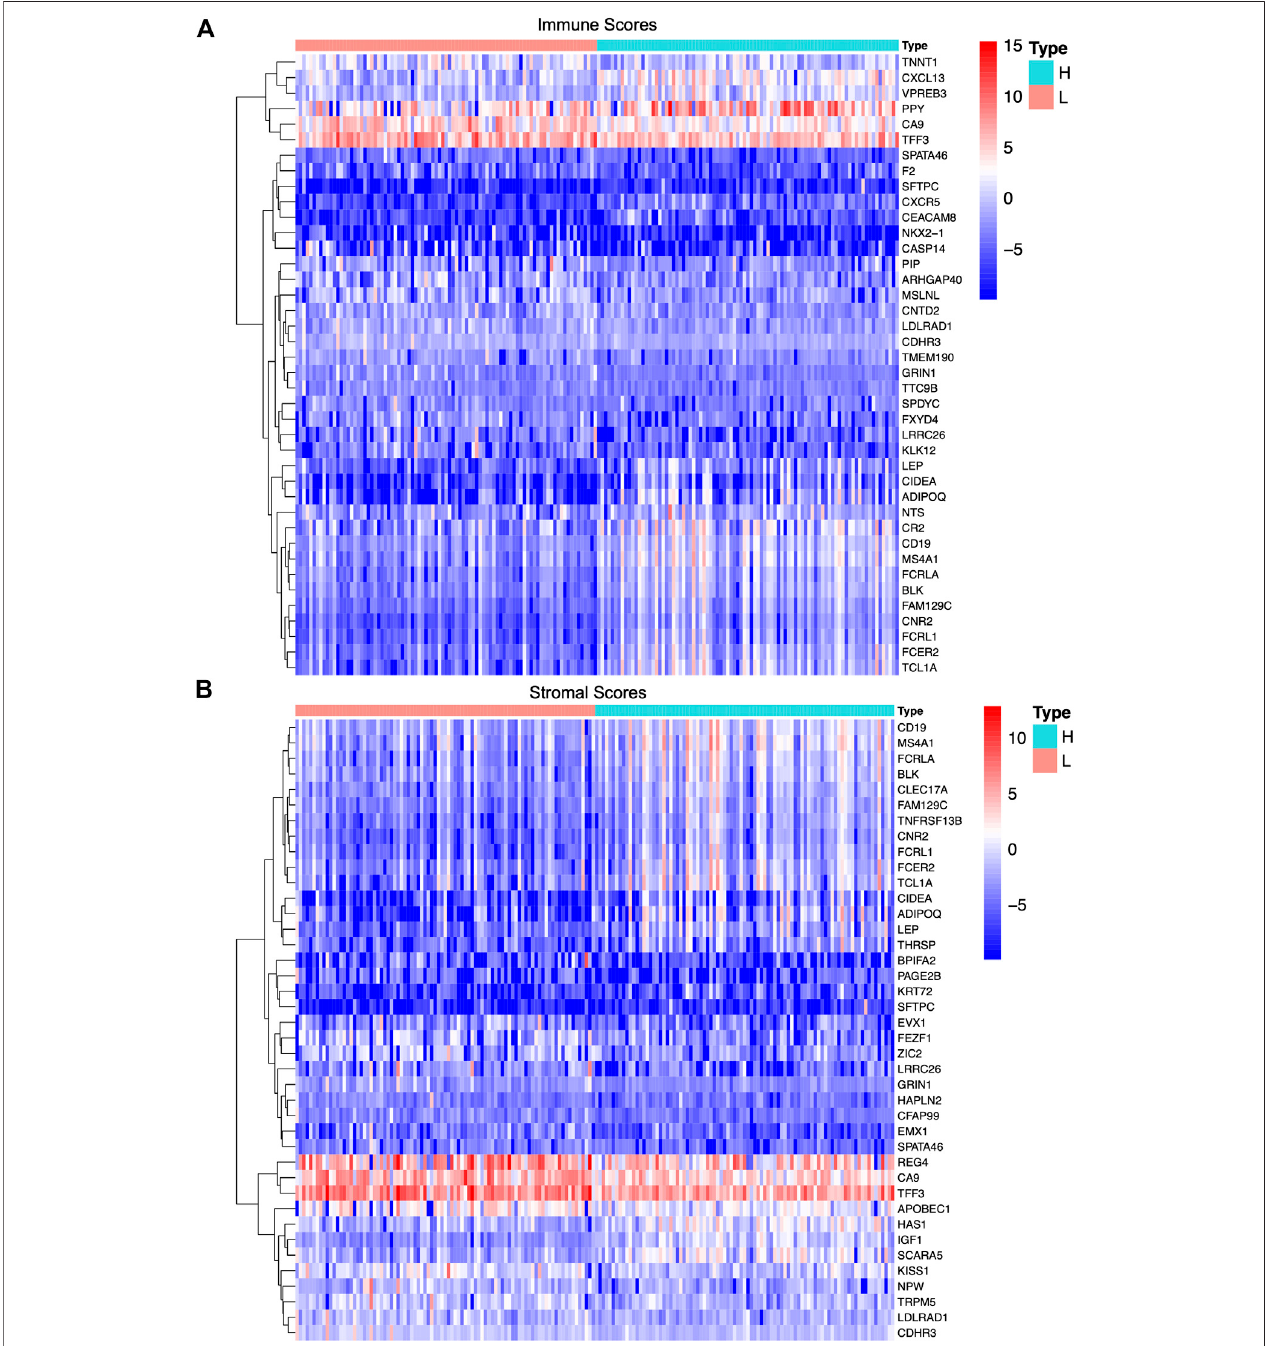
FIGURE 3 | Differentially expressed genes in immune scores and stromal scores of PAAD samples. (A,B) Heat-maps of top 20 differentially expressed genes betweenhighscoregroupandlowscoregroupbasedonimmunescoreandstromalscorewiththethresholdvalueof p < 0.05and|logfoldchange| > 1byWilcoxonrank- sum test,